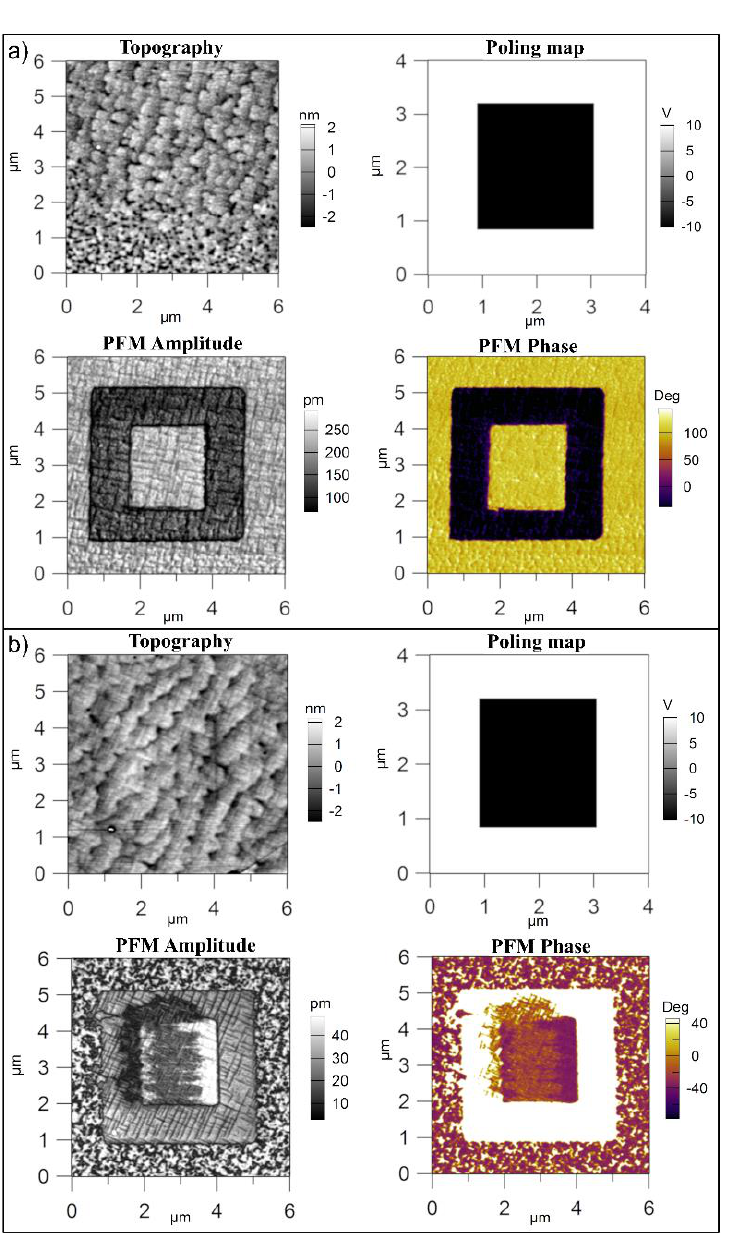
Figure 3. T opography, poling map, PFM amplitude, and phase for ( a ) PZT-CO and ( b ) PZT-IH